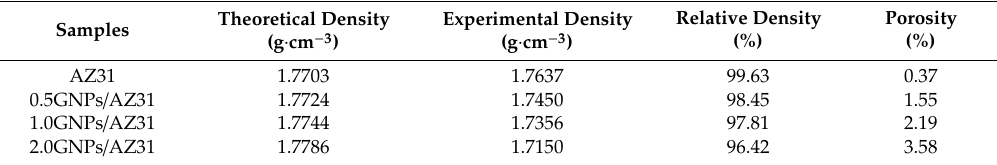
Table 2. Density and relative density of the as-extruded AZ31 and GNPs / AZ31 composites.